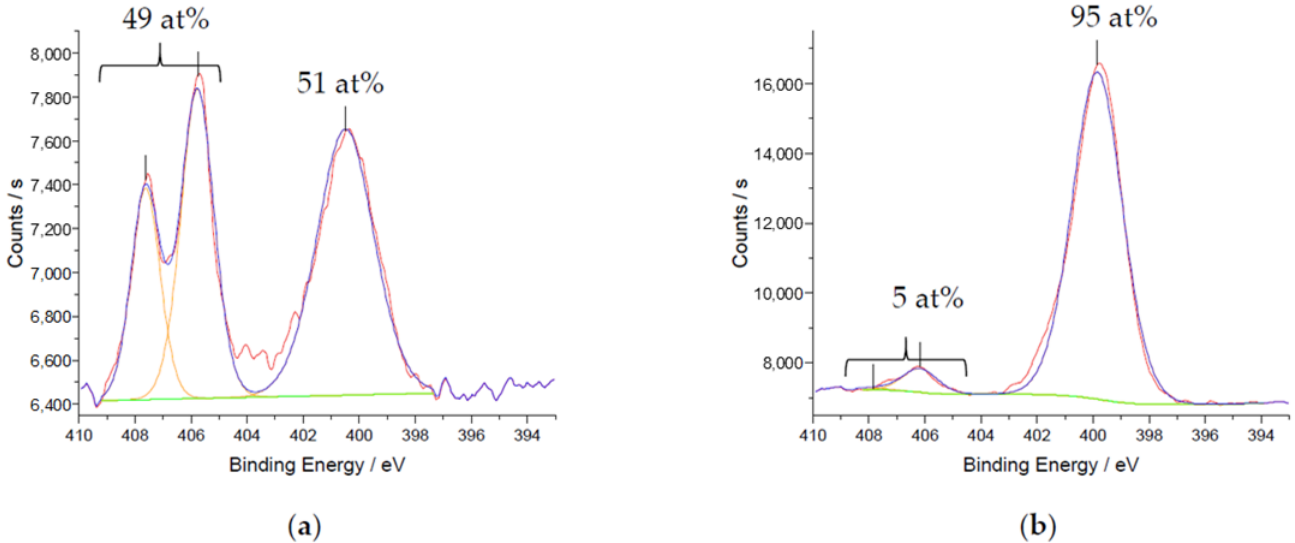
Figure 8. N 1 s high-resolution XPS spectra of pp lim deposited at a lim flow rate of 10 g ∙ h −1 and ( a ) air and ( b ) nitrogen as ionization gas. ( a ) air and ( b ) nitrogen as ionization